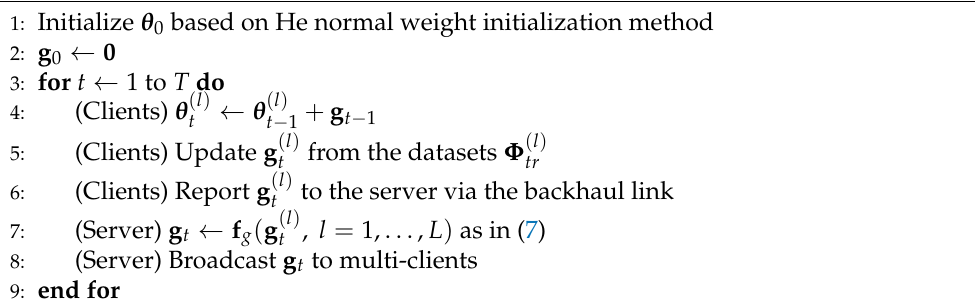
Algorithm 1 Generalized federated learning train